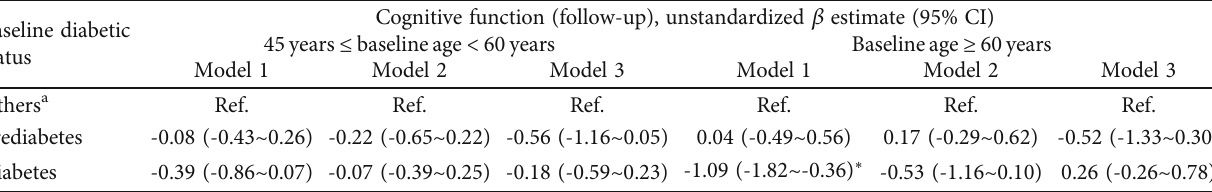
Table 4: Eight-year association between baseline diabetic status and subsequent cognitive function according to age. Baseline diabetic